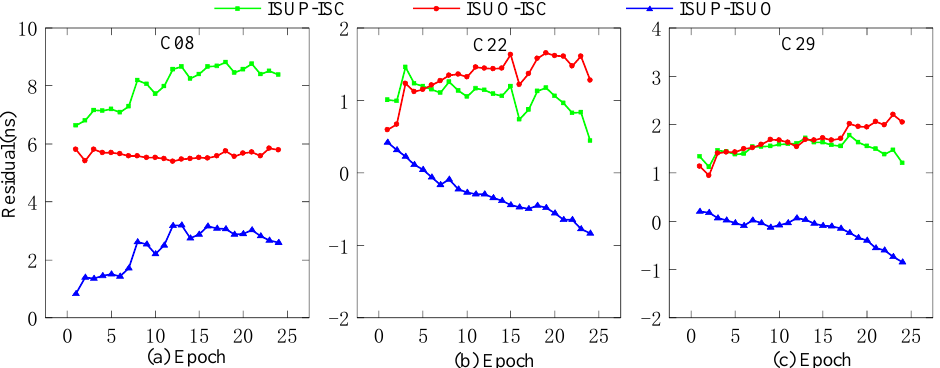
Figure 4. The residual plot of the Rb-II clock as the reference clock. ( a ) The residual value of C08 predicted after 6 h. ( b ) The residual value of C22 predicted after 6 h. ( c ) The residual value of C29 predicted after 6 h.